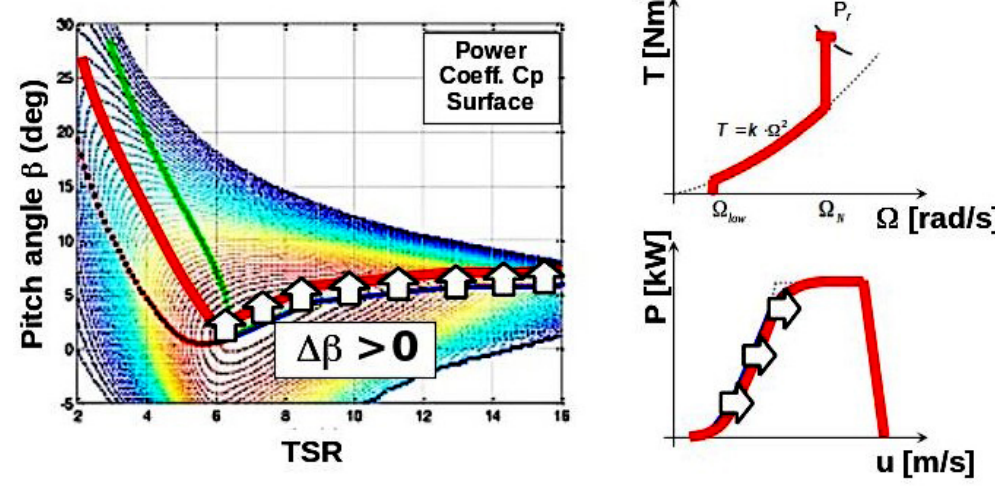
Figure 6. Effect of pitch angle offset toward higher angles in the turbine